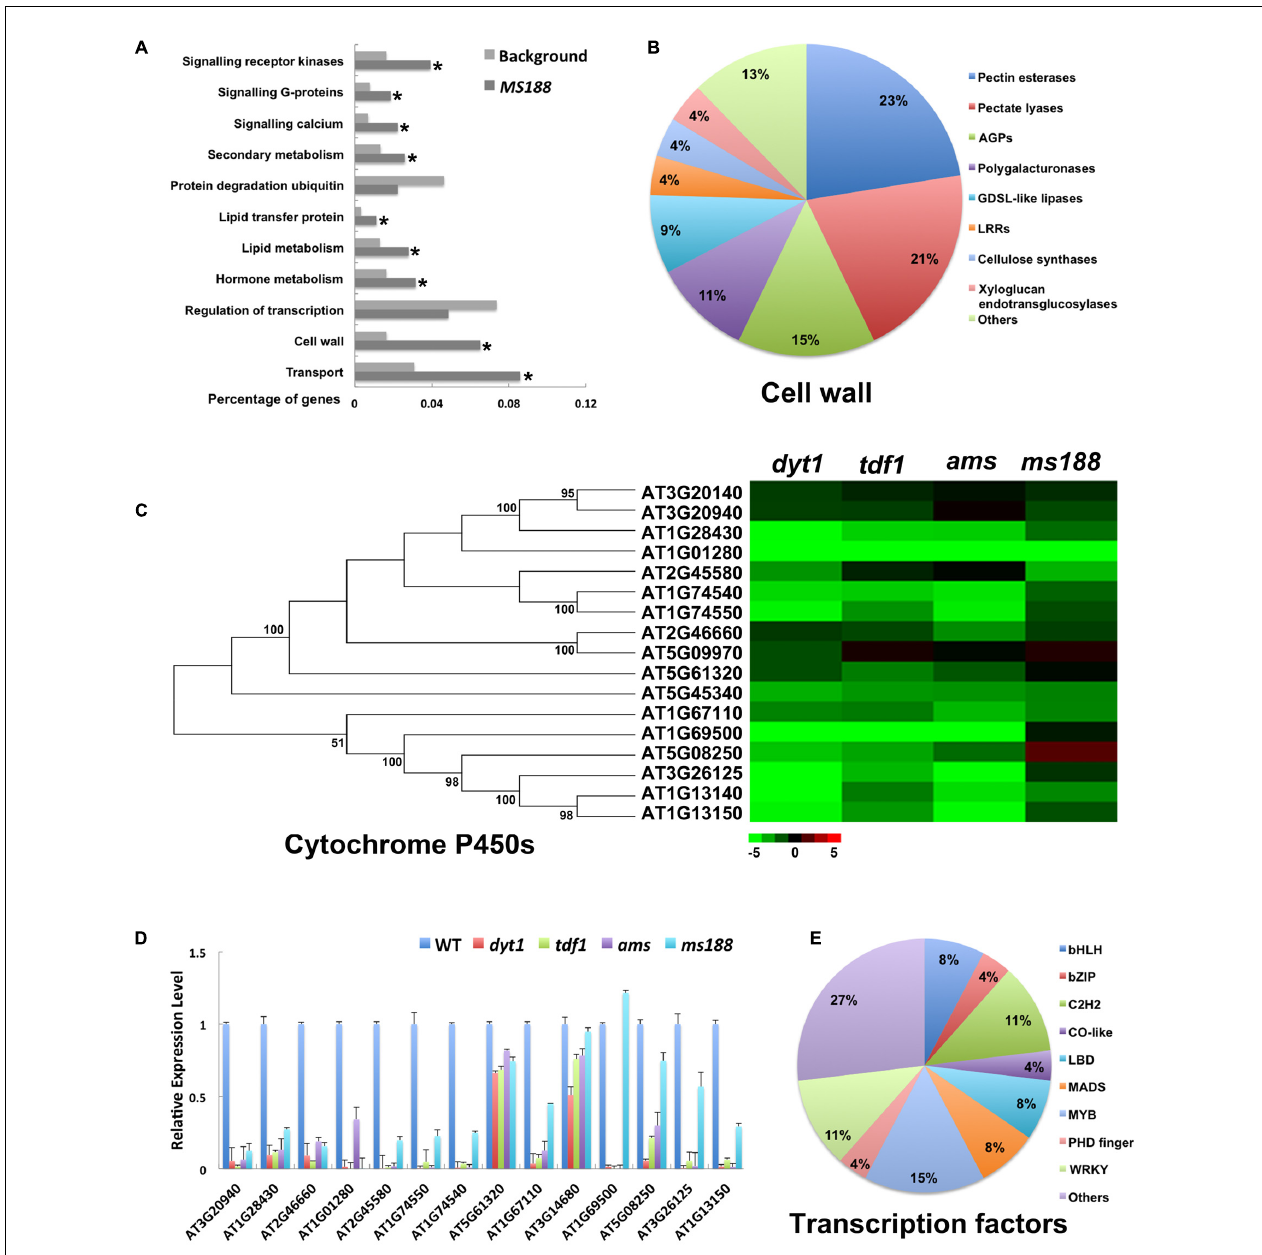
FIGURE 6 | Functional analysis of commonly expressed genes down-regulated in the four mutants. (A) GO enrichment analysis of common genes. (B) Subsets of cell wall related genes in common genes. (C) Heat map of mRNA expression profiles of cytochrome P450 family genes in dyt1 , tdf1 , ams , and ms188